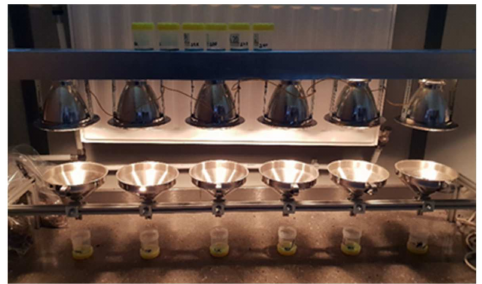
Figure 2. Tullgren funnels utilized for the collection of